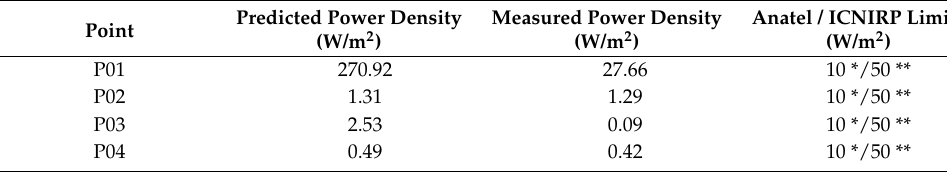
Table 4. Predicted and Measured Power Density.